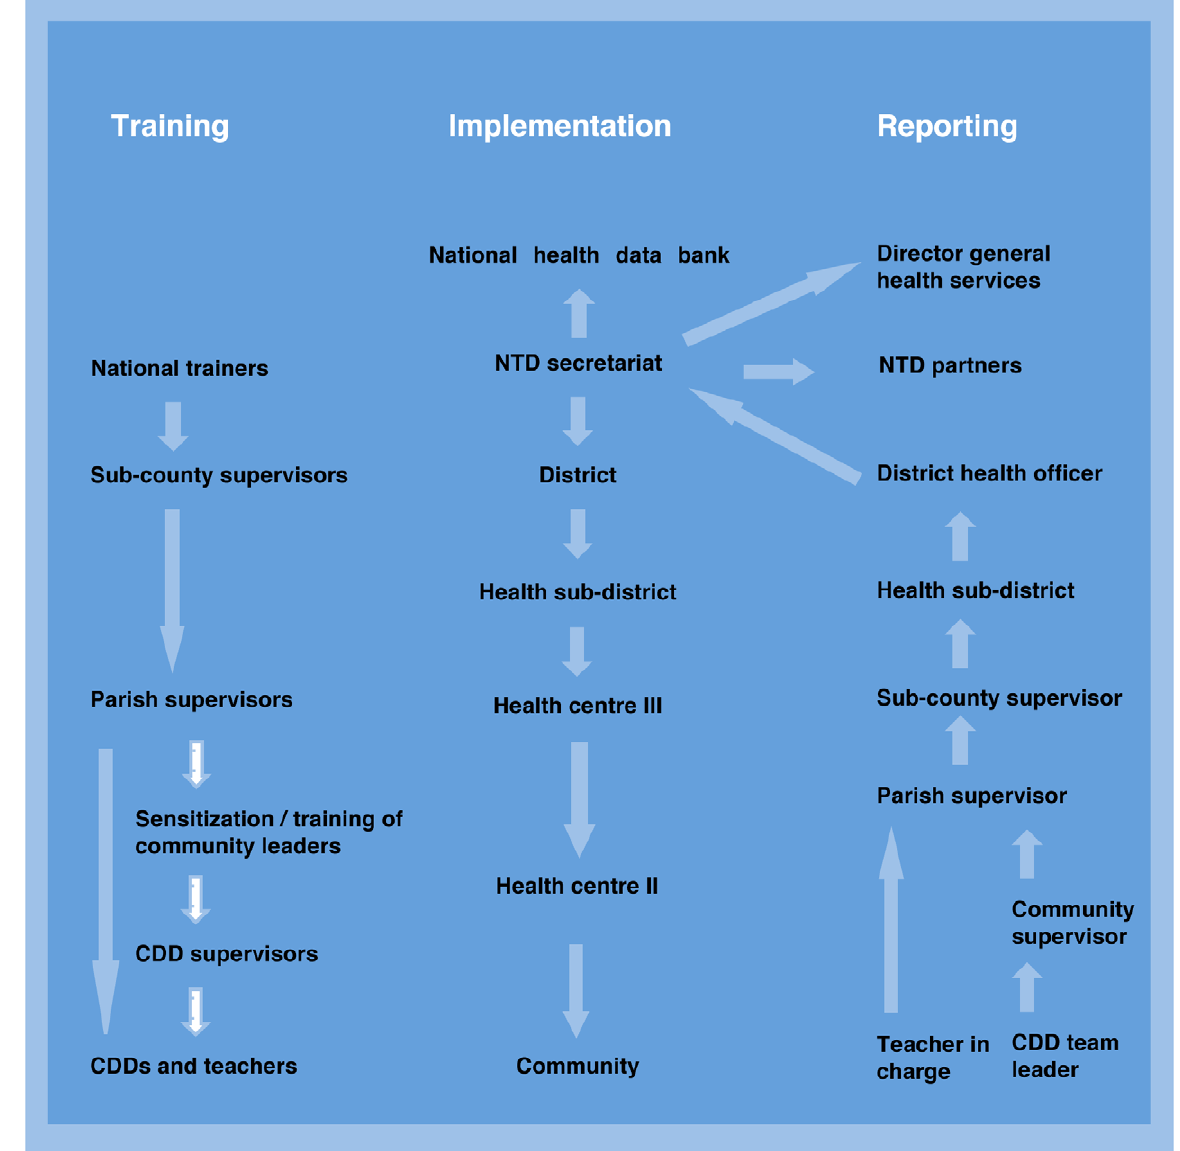
Figure 3. Training, implementation and reporting flow for NTDs integrated into Uganda’s health system, including an alternative approach often used by NGOs (see white arrows). The training cascade is initiated by existing MoH staff at a central level, referred to as the national technical team. This team trains district trainers from subcounty or health subdistricts. These trainers then return to their duty stations to organize and coordinate training in their geographical areas. Within each area, parish supervisors and peripheral health centre staff are trained